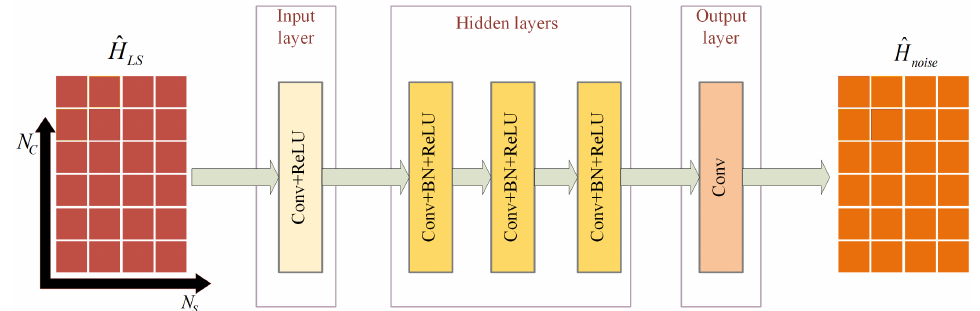
Figure 2. The network structure of the